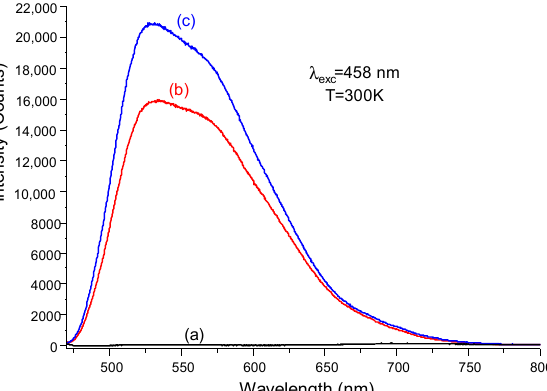
Figure 4. Room temperature emission spectra recorded under a 458 nm excitation for ( a ) ZnO NW arrays alone, ( b ) YAG:Ce coating alone and ( c ) YAG:Ce coating covered by ZnO NW arrays. Excitation source stroke in front of the sample at 45°.